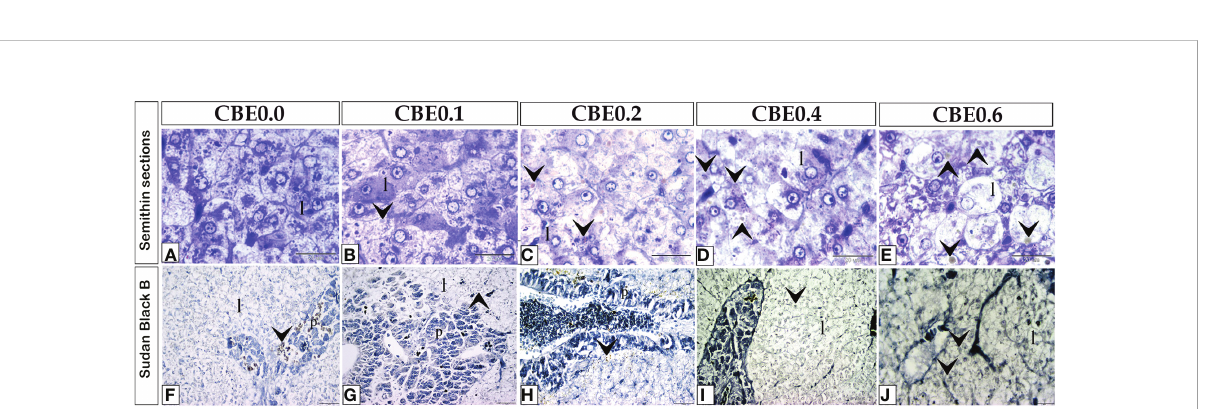
FIGURE 8 Semithin sections (A – E) stained with toluidine blue and frozen sections (F – J) stained with Sudan Black B revealed the variation of hepatocyte size and lipid content in response to feed on varied CBE dosages. (A – E) Increase in the size of liver cells (l) in the treated groups as compared to the control group. (F – J) Within the liver cells (I), fat content increased in the treated groups compared to the control